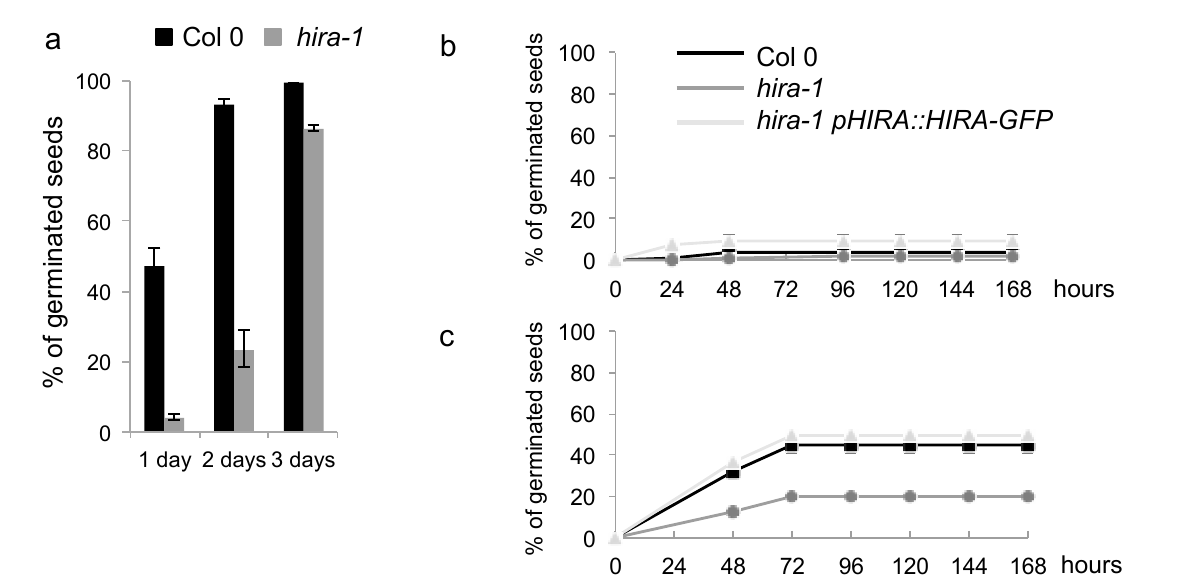
Figure 3. Seeds lacking HIRA show enhanced seed dormancy. Dormancy defects induced by HIRA loss-of-function ( a ) Germination of freshly harvested seeds of Col-0 (black) and hira-1 mutants (dark grey) in darkness at 25 °C after one, two and three days of stratification. Percentage of germinating seeds was scored six days after transfer to 25 °C. ( b , c ) Germination of freshly harvested seeds of Col-0 (black), hira-1 mutants (dark grey) and the complementing line ( hira-1 pHIRA::HIRA-GFP ; light grey) in darkness at 25 °C without ( b ) and after three days of stratification at 4 °C ( c ). Error bars correspond to SD from three biological replicates.